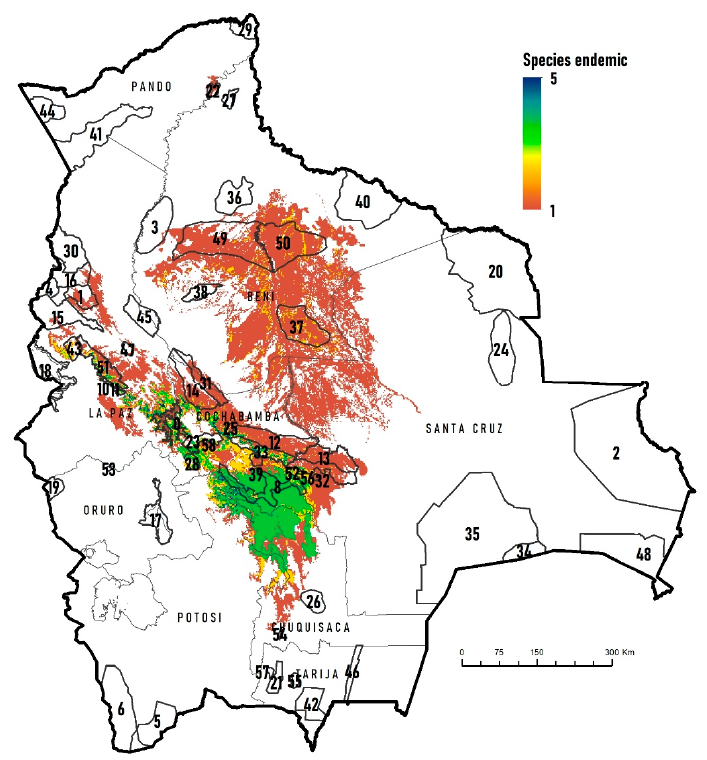
Figure 5. Endemic bird species in relation to the KBAs of Bolivia.